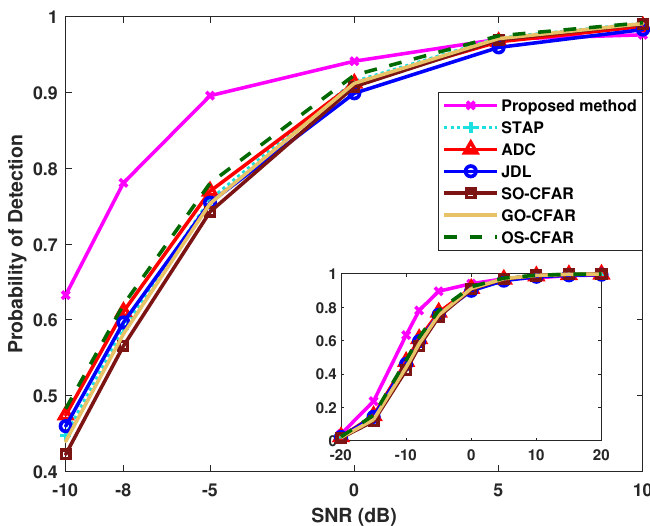
Figure 2. Comparison of detection probabilities with various SNRs. For further comparisons, a non-side-looking array with ϑ = − 75 ◦ is used to show the detection with various SNRs in Figure 3. Furthermore, different v a = 100 m/s, v c = 130 m/s and CNR = 40 dB are used. PFA = 5 × 10 − 4 for all of the analyzed methods. In these simulation situations, the JDL method provides the lowest detection probability. With about − 5 dB ≤ SNR ≤ 20 dB, the detection outcomes of STAP, ADC, SO-CFAR, GO-CFAR and OS-CFAR methods are good. However, when SNR is located at SNR = − 20 to SNR = − 5 dB, the proposed method performs the best.